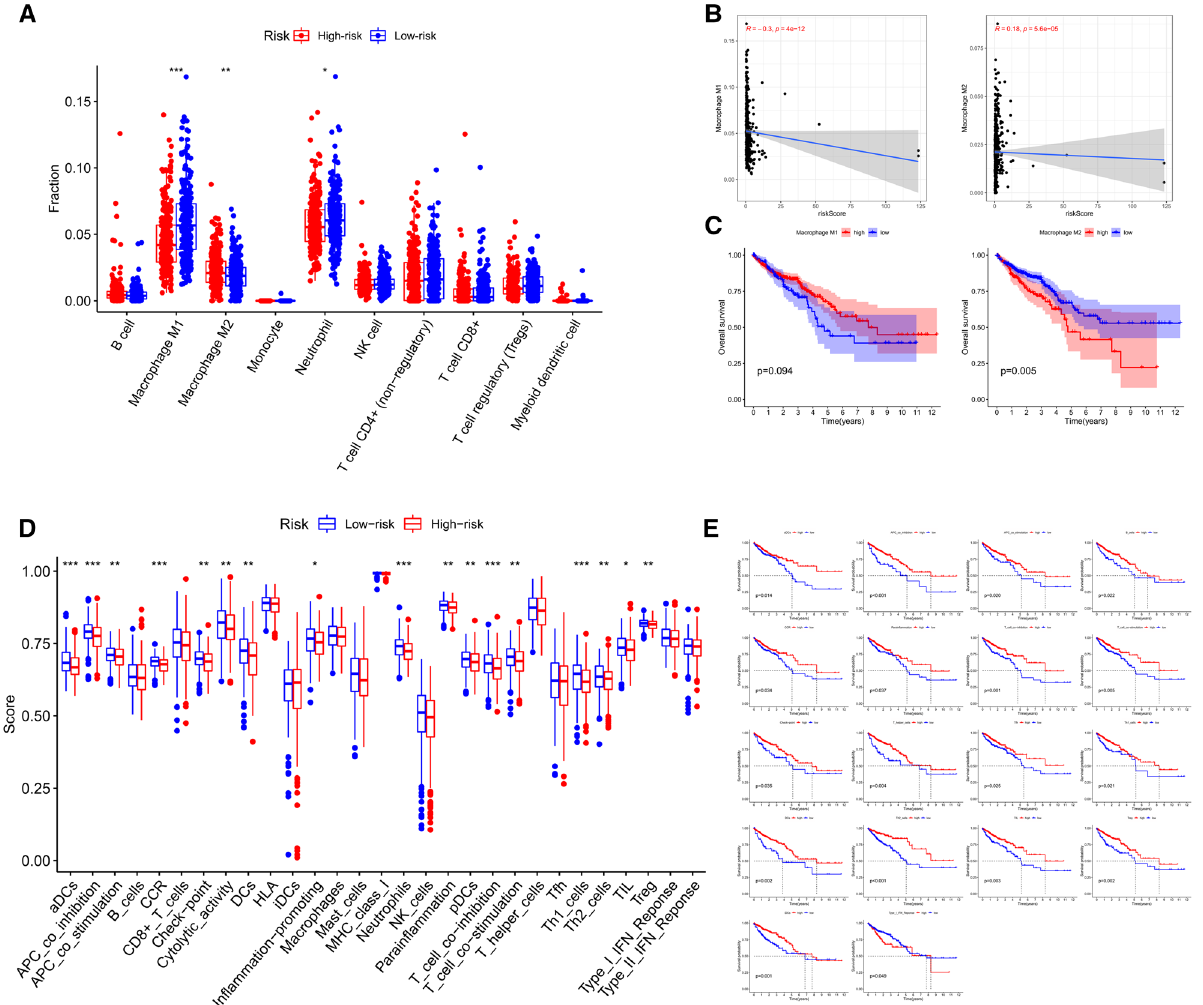
Figure 7. The correlation between the risk signature and immune status. ( A ) Relationship between the risk signature and 10 kinds of TIICs based on QUANTISEQ algorithm. ( B ) Estimation of the coefficients for risk score with the abundances of Macrophage M1 and Macrophage M2 based on Spearman correlation analysis. ( C ) Prognostic value of Macrophage M1 and Macrophage M2 in CRC patients. ( D ) Comparisons of immune functions in different risk groups. ( E ) Prognostic value of distinct immune functions in CRC